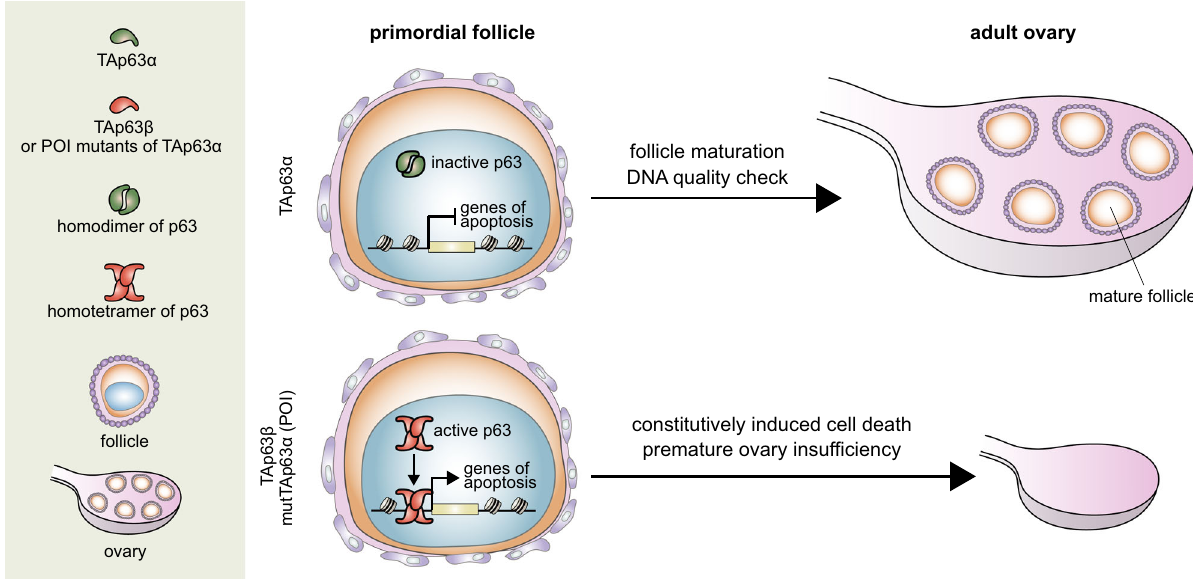
Fig. 6 Schematic model of TAp63 role in ovary physiology, in HET Δ 13p63 mouse model and in presence of POI mutations. Under normal physiological conditions, TAp63 α is present in dimeric inactive form, which can be activated only upon certain circumstances such us upon DNA damage. Activated TAp63 α enables DNA quality check to ensure the genomic stability of germline ovary development and follicle maturation. However, TAp63 β , as well as POI mutants of p63, form active tetramers which constitutively induce cell death, leading to premature ovarian insuf fi